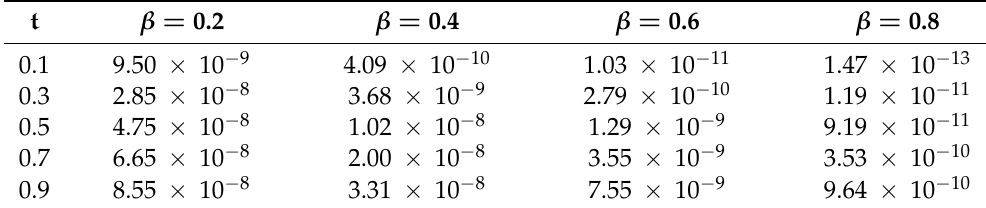
Table 4. Error analysis of LHPM in fractional domain for time-fractional Sawada–Kotera model (Example 1) when k = 0.15 and x =